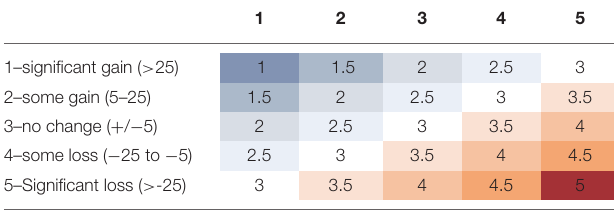
TABLE 2 | Vulnerability assessment scoring